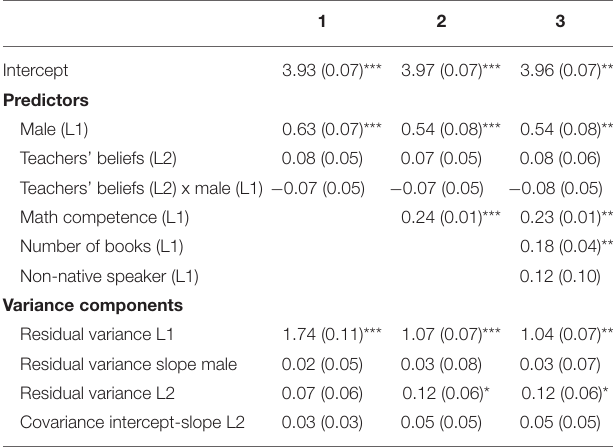
TABLE 3 | Regression of teachers’ aptitude ratings on students’ gender and teachers’ math brilliance